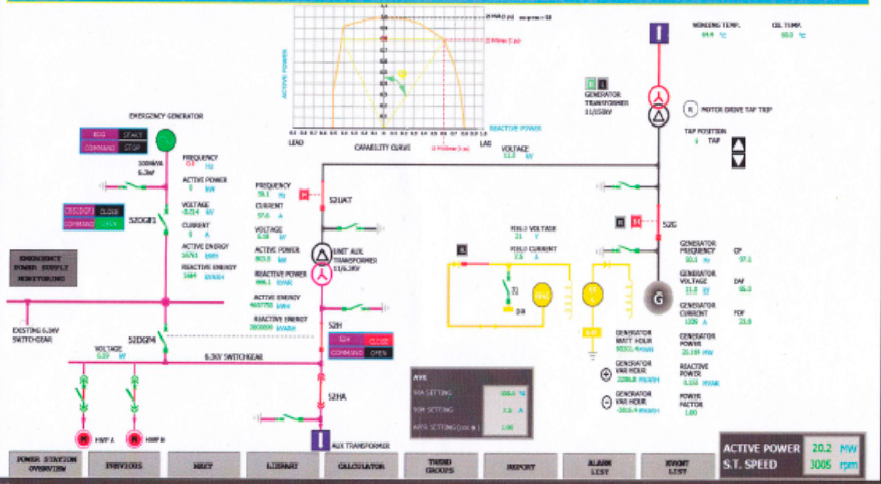
Figure 18. Original capability curve from the generator in Lahendong IV geothermal power plant.